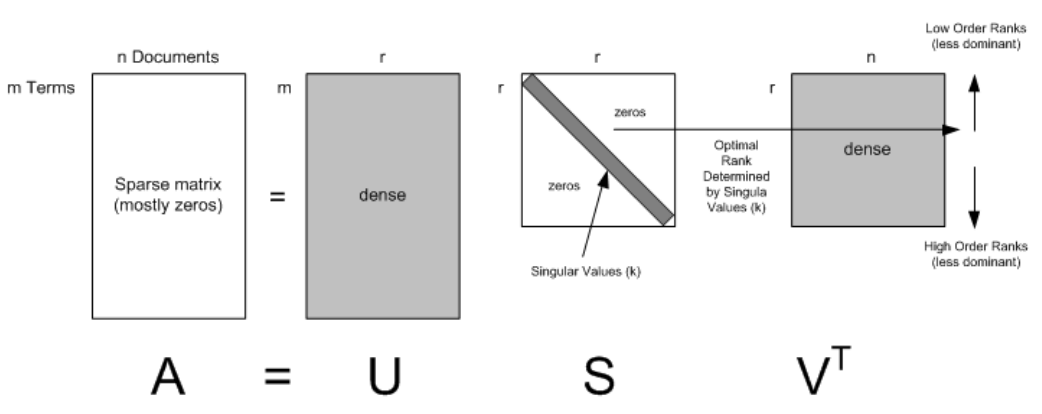
Figure 3. SVD Representation of the document-term(s)